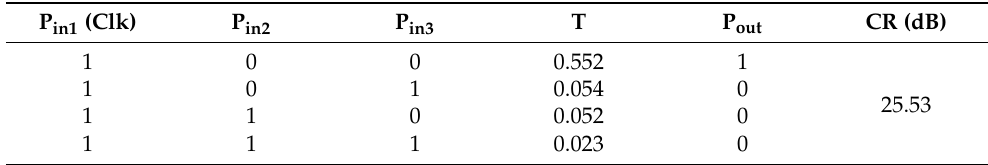
Figure 12. Light field distributions for NOR function utilizing 2 × 2 silicon waveguide at 1.55 µ m. Table 6 provides a summary of the simulation findings for the NOR gate with CR = 25.53 dB. Table 6. Simulation findings for NOR (T th = 0.14).